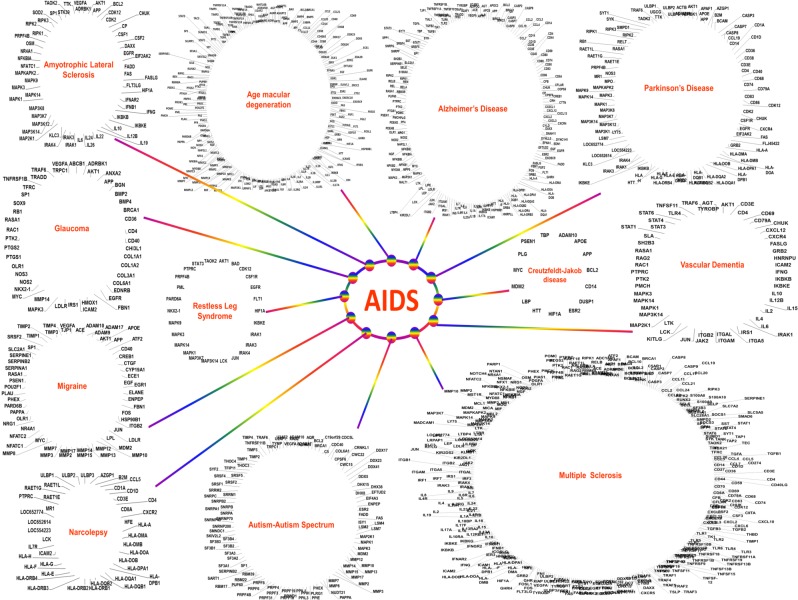
AIDS share common molecular pathways (genes) with different neurological disorders (please see S2 Data for details): neighboring gene network of each neurological disorder was compared (Venn Analysis) with that of AIDS to obtain their shared genes.All at-risk genes (S4 Data) for Schizophrenia, major depression, Bipolar and Attention Deficit Hyperactivity Disorder overlapped with Autism spectrum and as such was not classified as a separate disease.